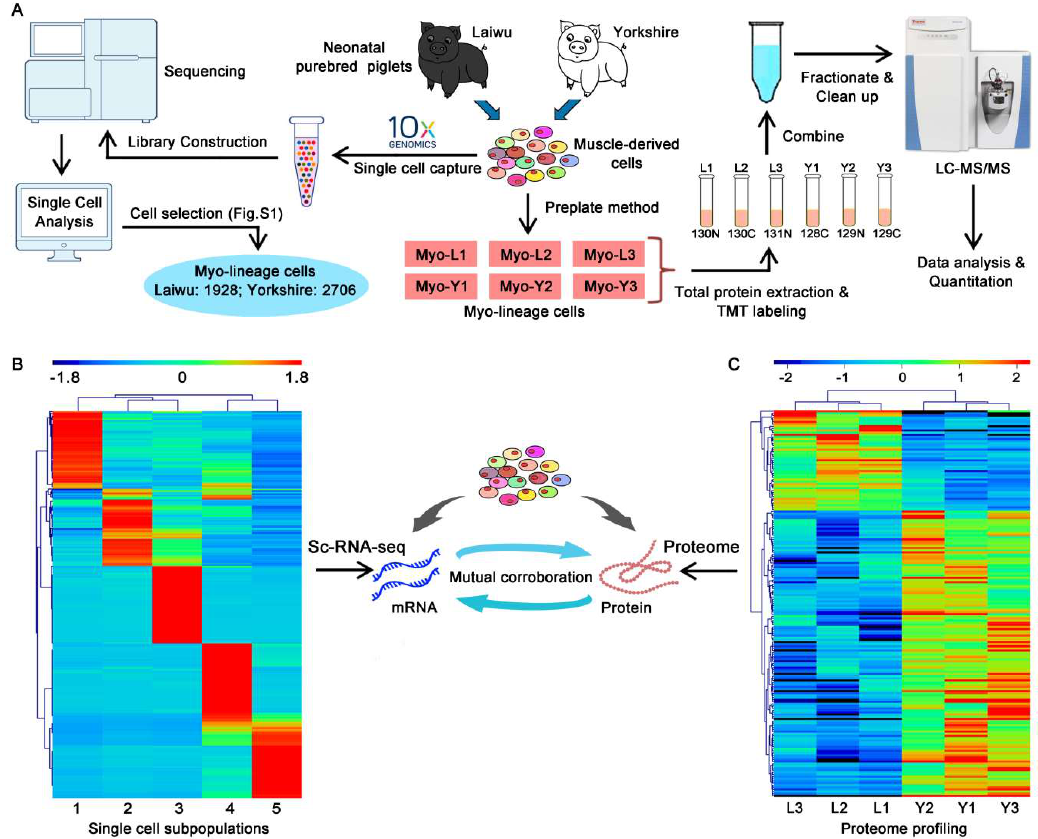
Figure 2. Single-cell RNA sequencing and proteomics analysis of Myo-lineage cells derived from obese- and lean-type pigs. ( A ) Technical process of single-cell RNA sequencing and proteomics analysis. ( B ) The major genes (top-100 selectively expressed in each group) for classification of Myo-lineage cells. ( C ) Hierarchical clustering of differentially expressed proteins. Heat-map was generated by MeV (4.9.0). Myo-L: Myo-lineage cells derived from skeletal muscle of obese-type pigs; Myo-Y: Myo-lineage cells derived from skeletal muscle of lean-type pigs.